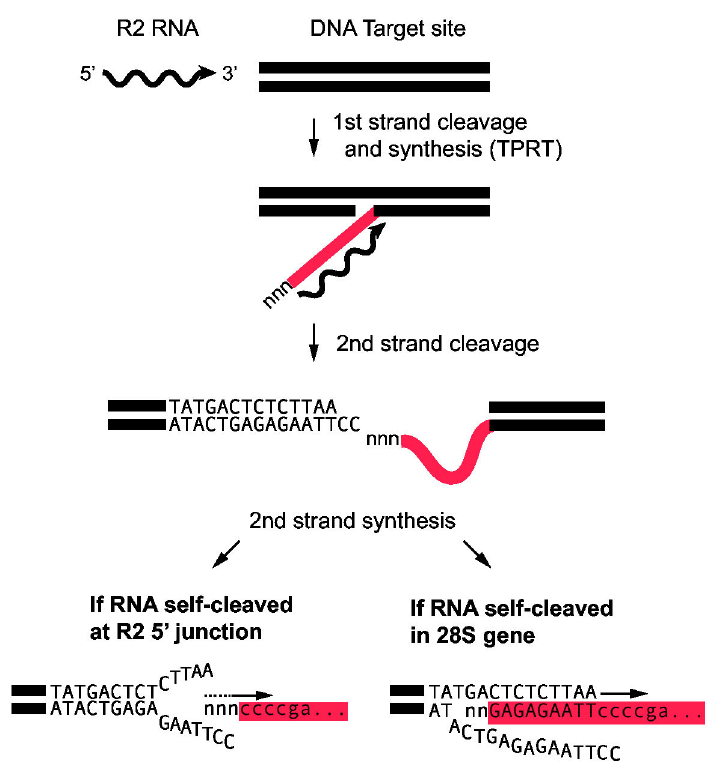
Figure 7. Models for the priming of second strand DNA synthesis in an R2 retrotransposition reaction. The initial steps of R2 integration are well characterized [41] and believed to be the same for all species. The R2 protein (not shown) recognizes the 3' UTR of the R2 RNA, binds to the 28S DNA target site, and cleaves the bottom strand. This cleavage site is used to prime first stand DNA synthesis which is referred to as target primed DNA synthesis, TPRT (cDNA, red line). Additional/non-templated nucleotides were shown to be added to the cDNA as the polymerase runs off an RNA template [42]. Priming of second strand DNA synthesis is proposed to differ between species based on whether the R2 RNA underwent self-cleavage at the R2 5' junction or upstream in the 28S gene. In the former, the R2 reverse transcriptase is able to use regions of microhomology of the cDNA with the DNA target upstream of the insertion site to initiate second strand DNA synthesis. This priming can involve the extra nucleotides added to the cDNA strand and can give rise to different length deletions of 28S sequences (lower left). In those animals where RNA self-cleavage is in the upstream 28S sequences, a heteroduplex between the cDNA and the target DNA is predicted to stabilize the integration intermediate resulting in a higher frequency of precise 5' junctions (lower